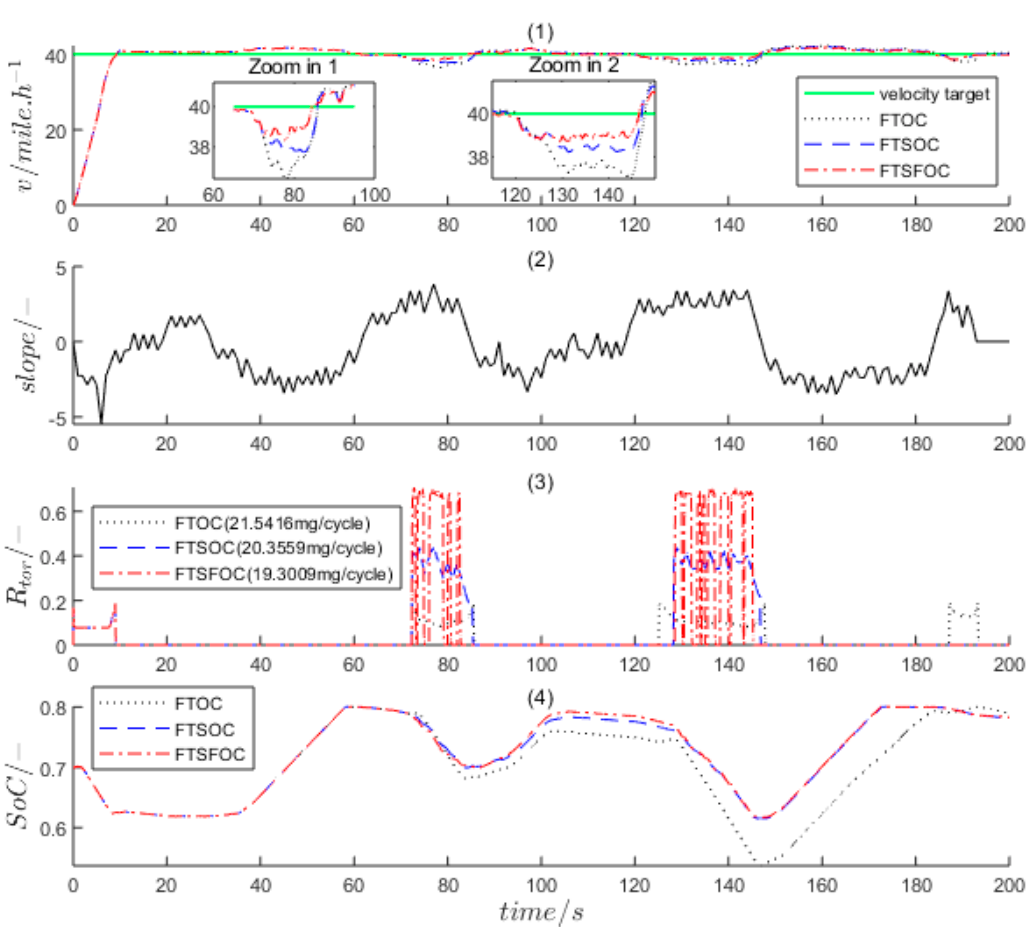
Figure 16. Comparison results of the FTOC vs. the FTSOC vs. the FTSFOC: ( 1 ) the speed target of the cycle and the tracking states of the controllers, ( 2 ) road grade, ( 3 ) R tor , ( 4 ) SoC